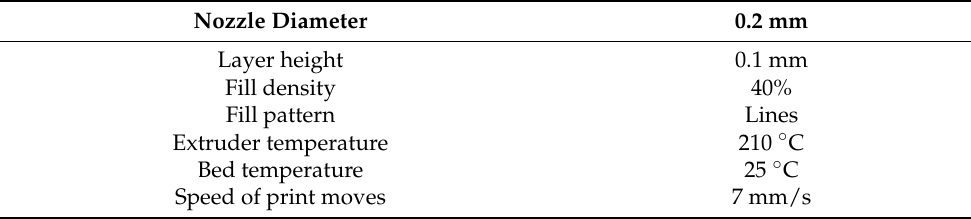
Table 2. Printer settings for producing the industrial polylactic acid (PLA) three-dimensional